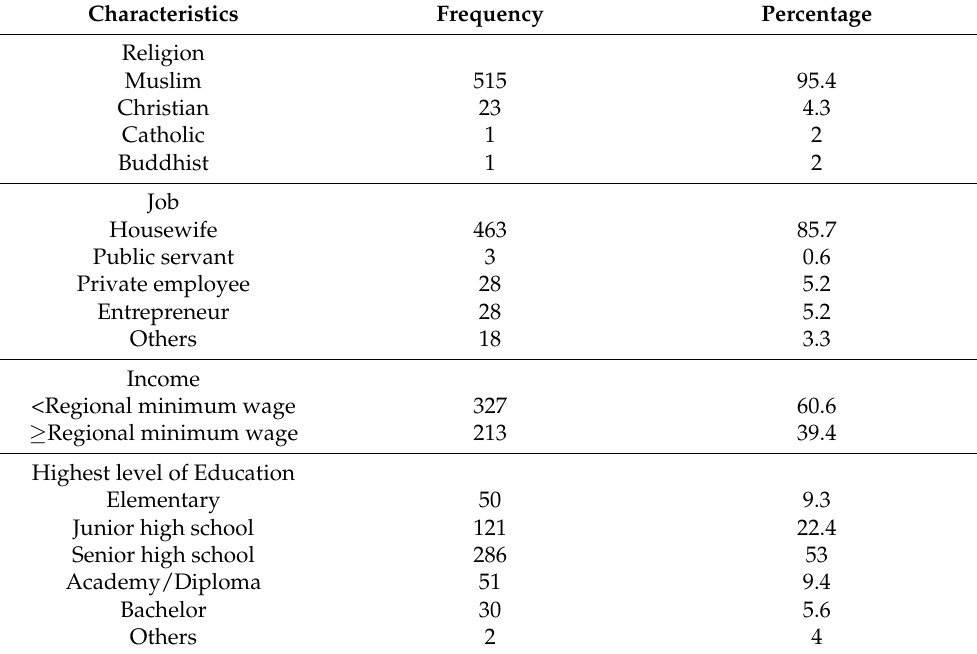
Table 1. Demographic data of caregivers.